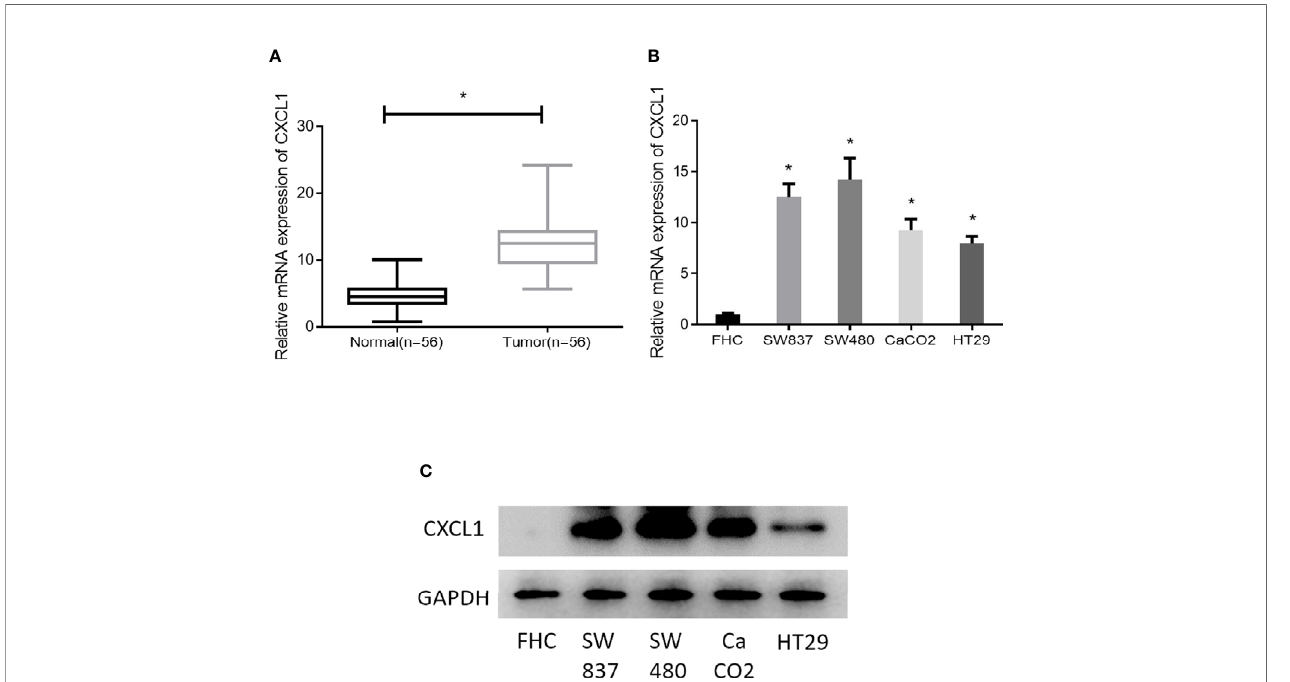
FIGURE 2 | CXCL1 is highly expressed in CRC. (A) qRT-PCR results showed the expression of CXCL1 in clinical tissue samples (normal: n = 56; tumor: n = 56), (B, C) Expression of CXCL1 mRNA and proteins in normal colorectal mucosa cell line FHC and CRC cell lines SW837, SW480, CaCO2, HT29, as examined by qRT- PCR and Western blot (* p <